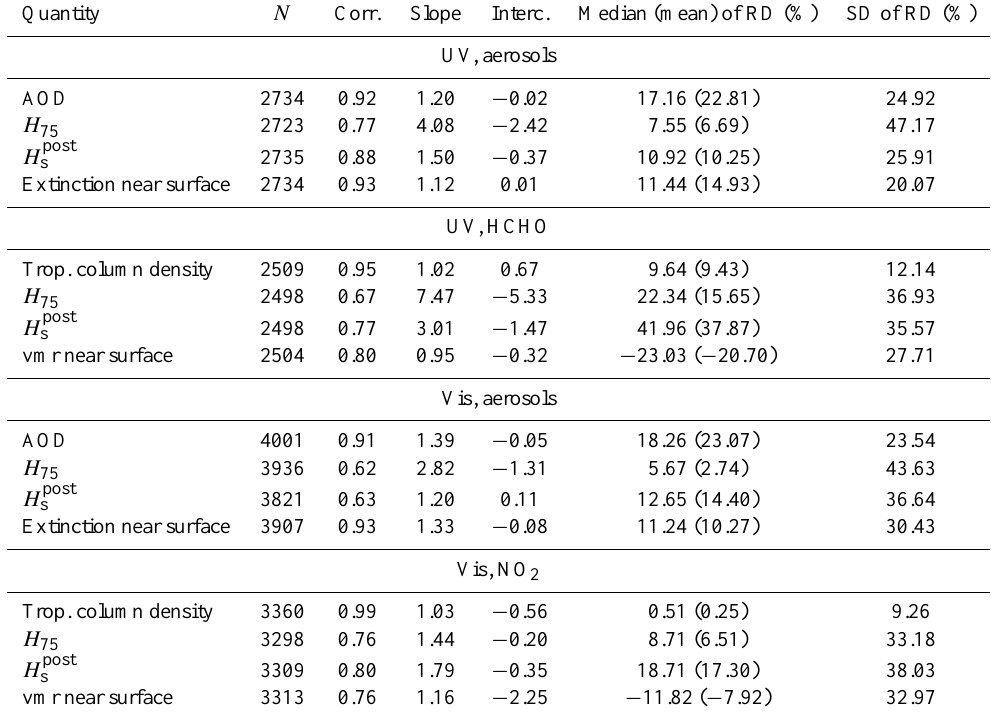
Table 3. Statistical comparison of methods A and B. The last two columns refer to median, mean and standard deviation (SD) of percentage relative differences (RD). The linear fit results are defined for method A on the abscissa. Relative differences have a sign determined by B post − A. Note that the intercepts have unit km for H 75 and H